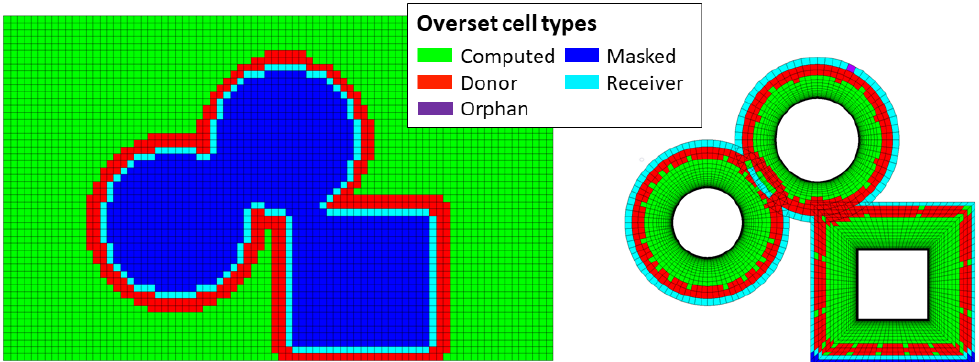
Figure 5. Overset mesh cell types and visualization of the hole cutting process forming a new boundary used for data interpolation between the mesh